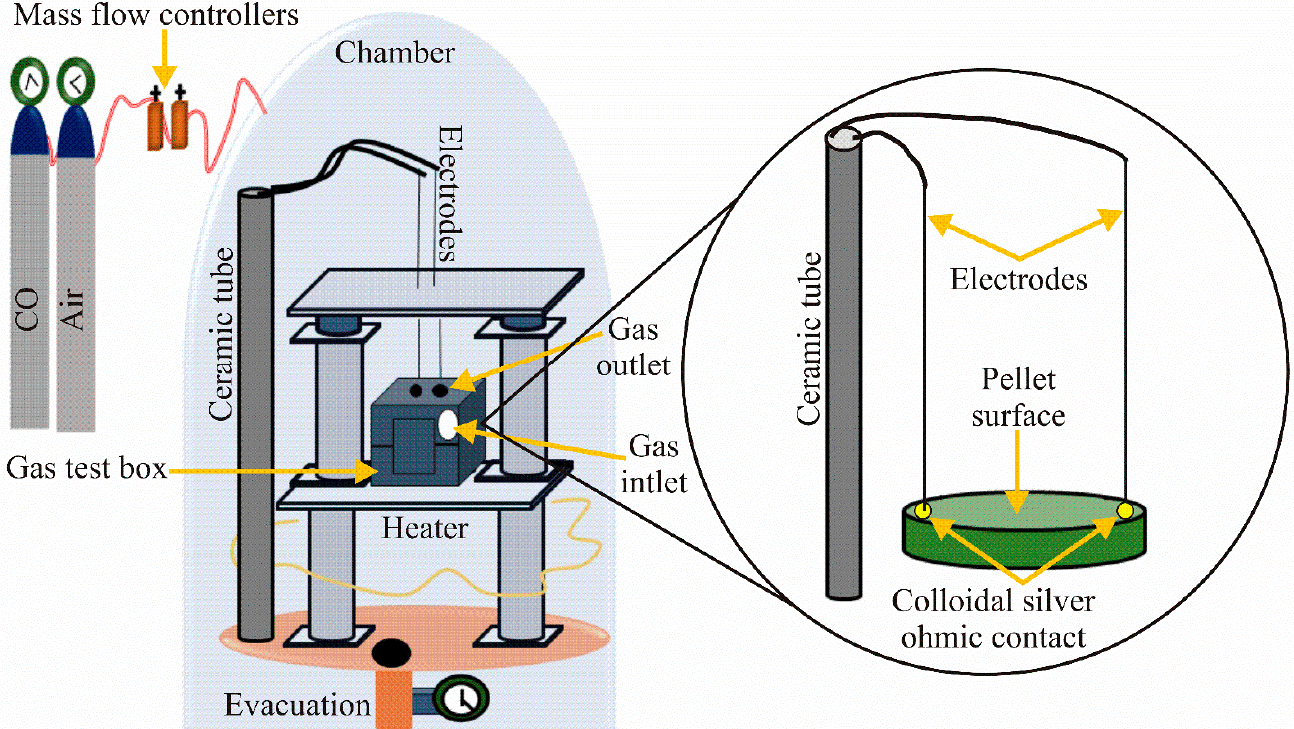
Figure 2. Schematic of the system employed in the static and dynamic tests in CO.